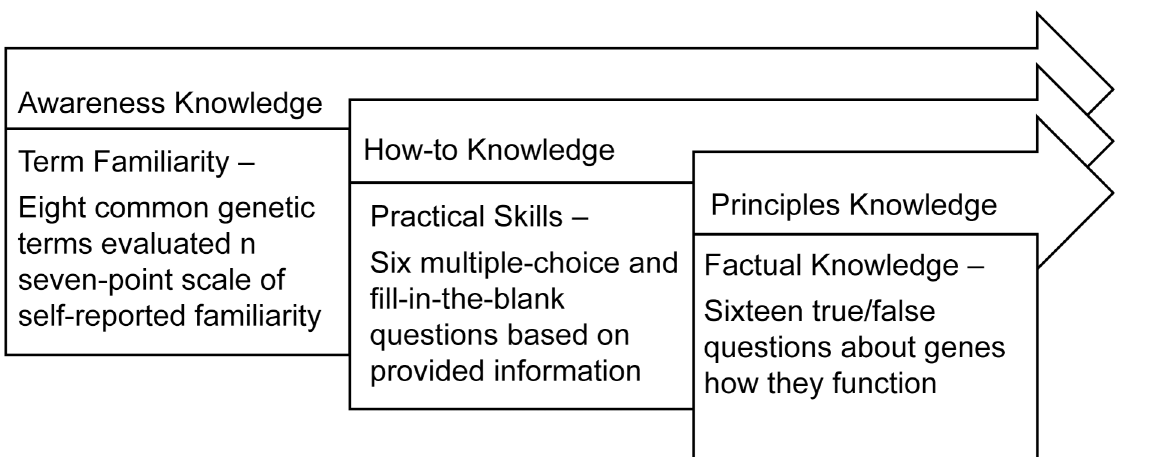
Fig 1. Applying Rogers ’ levels of knowledge to Genetic Literacy Survey